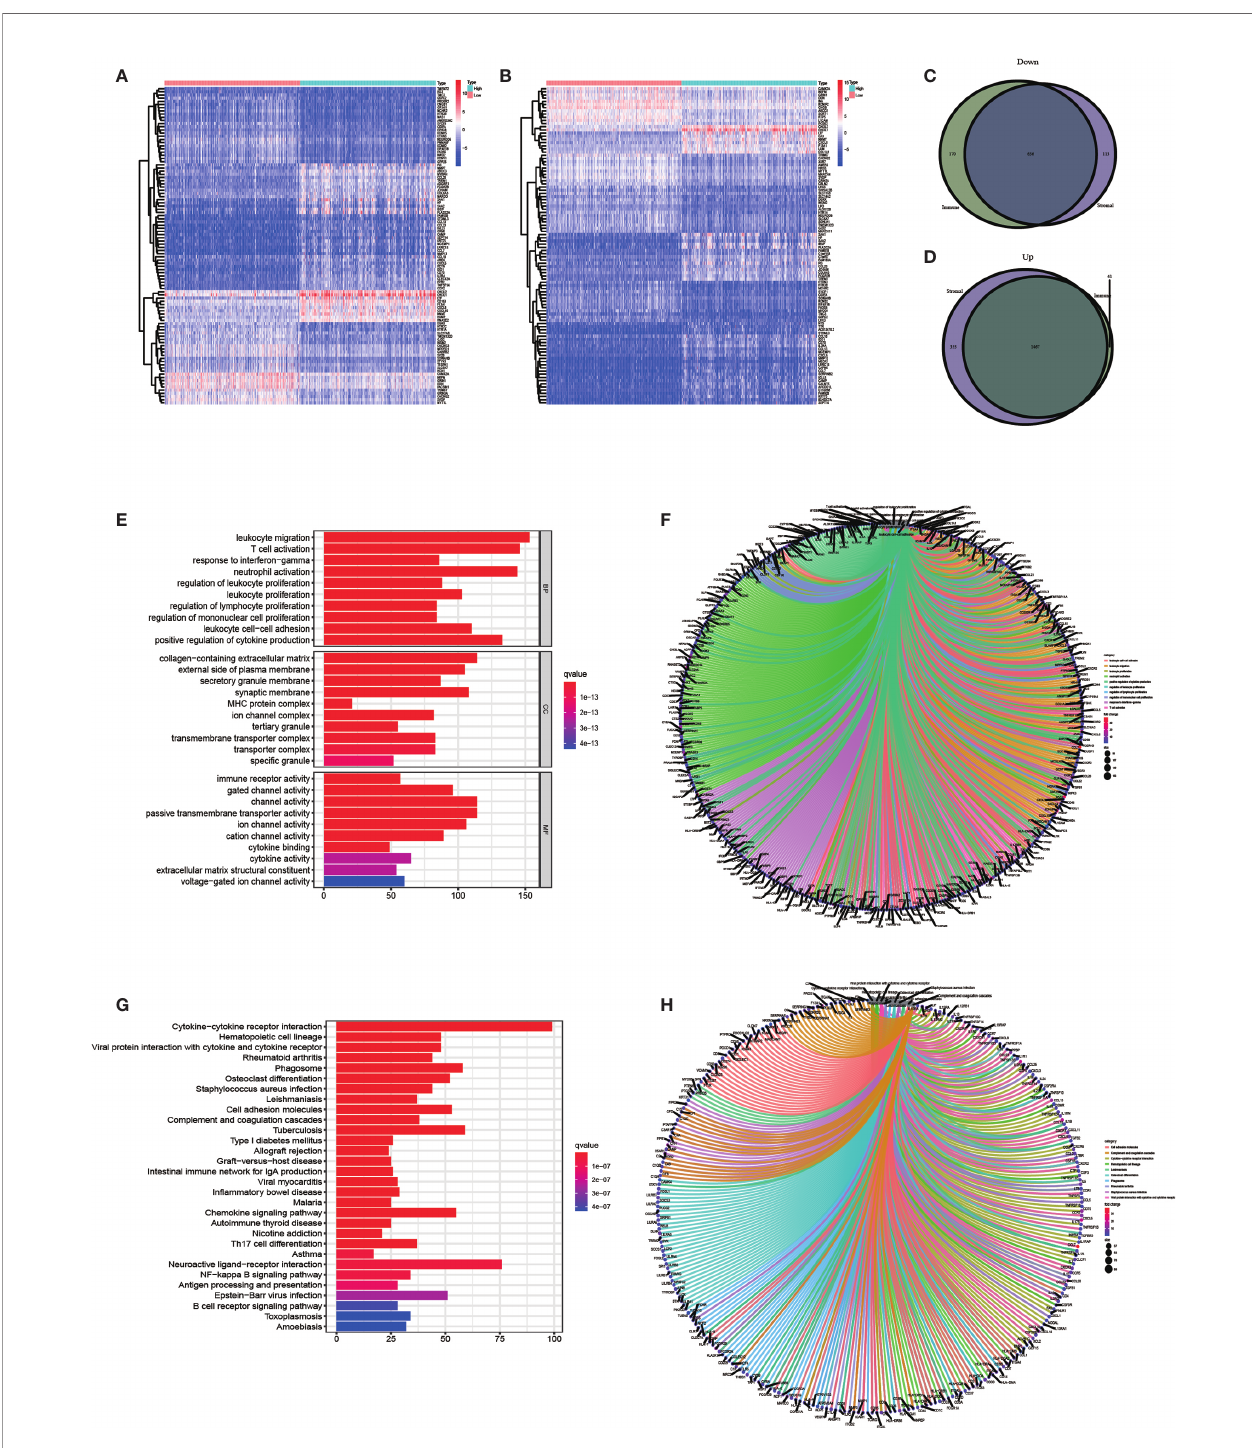
FIGURE 2 | DEGs obtained by the intersection of Immune Score and Stromal Score showed Immune-related pathway Enrichment. (A) The heatmap of the DEGs of Immune Score difference. (B) The heatmap of the DEGs of Stromal Score difference. (C) A total of 636 genes were down regulated both in immune and stromal components. (D) A total of 1467 genes were up regulated both in immune and stromal components. (E, F) The GO analysis showed that the DEGs were mainly enriched in immune-related pathways. (G, H) The KEGG analysis showed that the DEGs were mainly enriched in immune-related